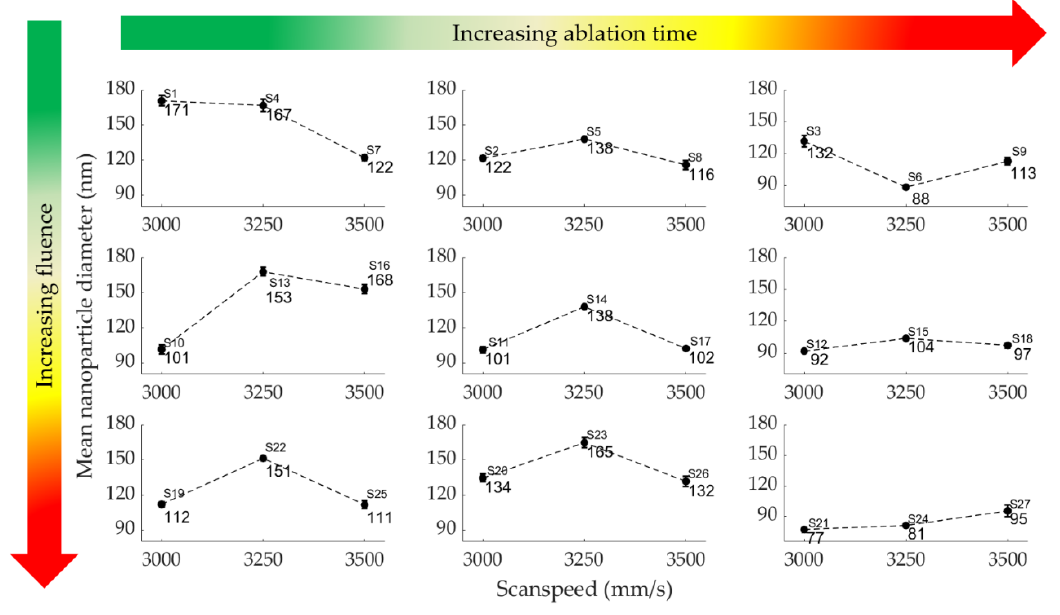
Figure 7. Effect of laser scan speed on nanoparticle mean diameter